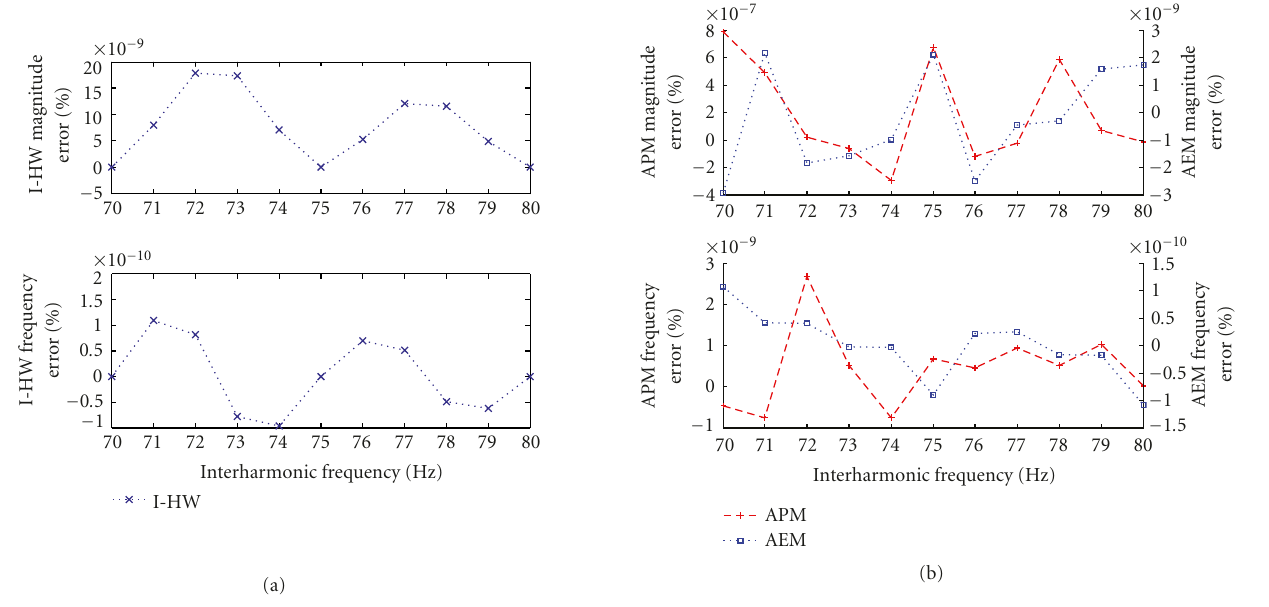
Figure 6: Case study 1: interharmonic amplitude and frequency error (in %) versus interharmonic frequency by smoothing the results over 15 intervals of 200 milliseconds: (a) I-HW (dotted line x ), (b) APM (dotted line +) and AEM (dotted line (cid:3)